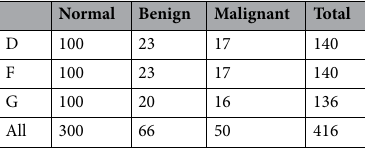
Table 1. Mammogram image patches distribution of MIAS